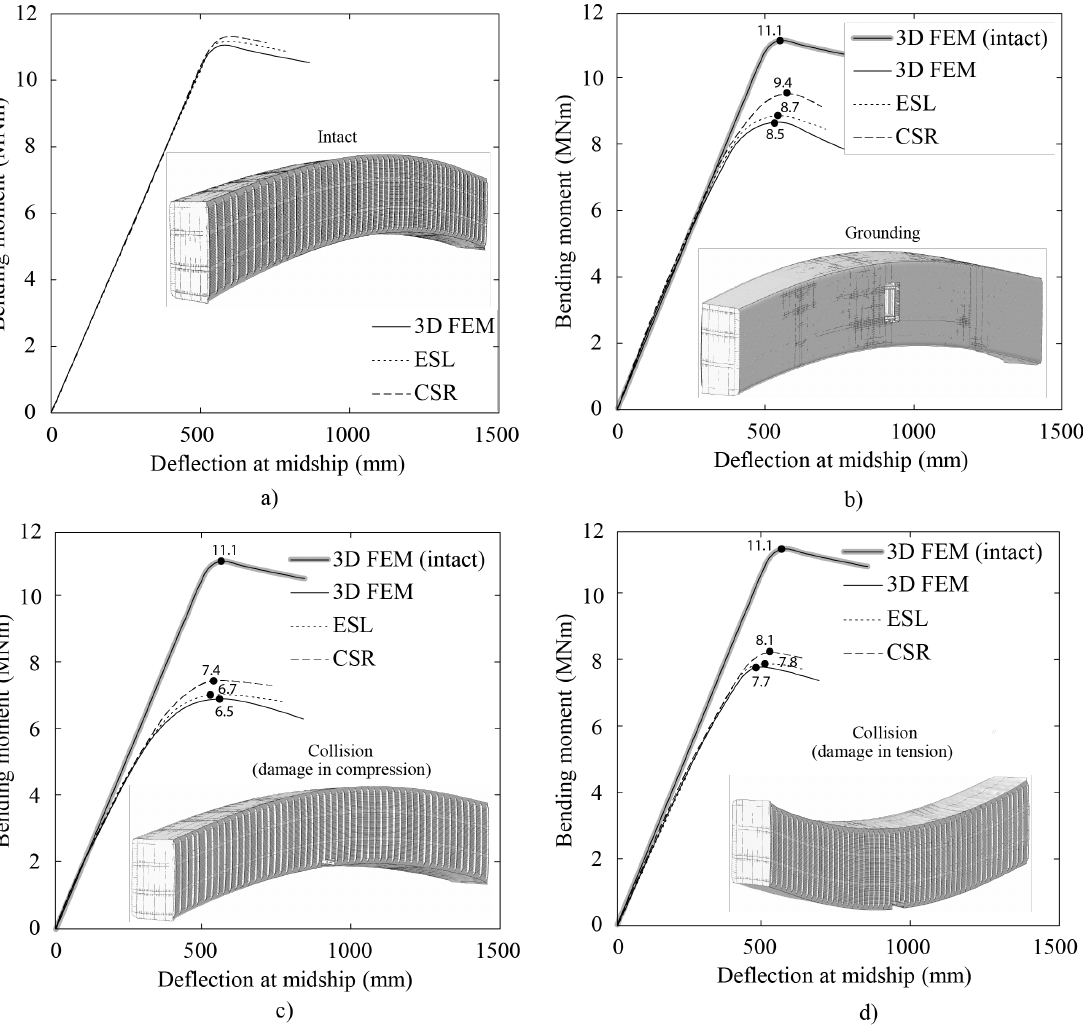
Figure 17. Horizontal bending moment-deflection relationships of tanker in the condition of ( a ) intact, ( b ) grounding, ( c ) collision with damage in compression, and ( d ) collision with damage in tension. The maximum bending moments are used in calculating the histogram in Figure